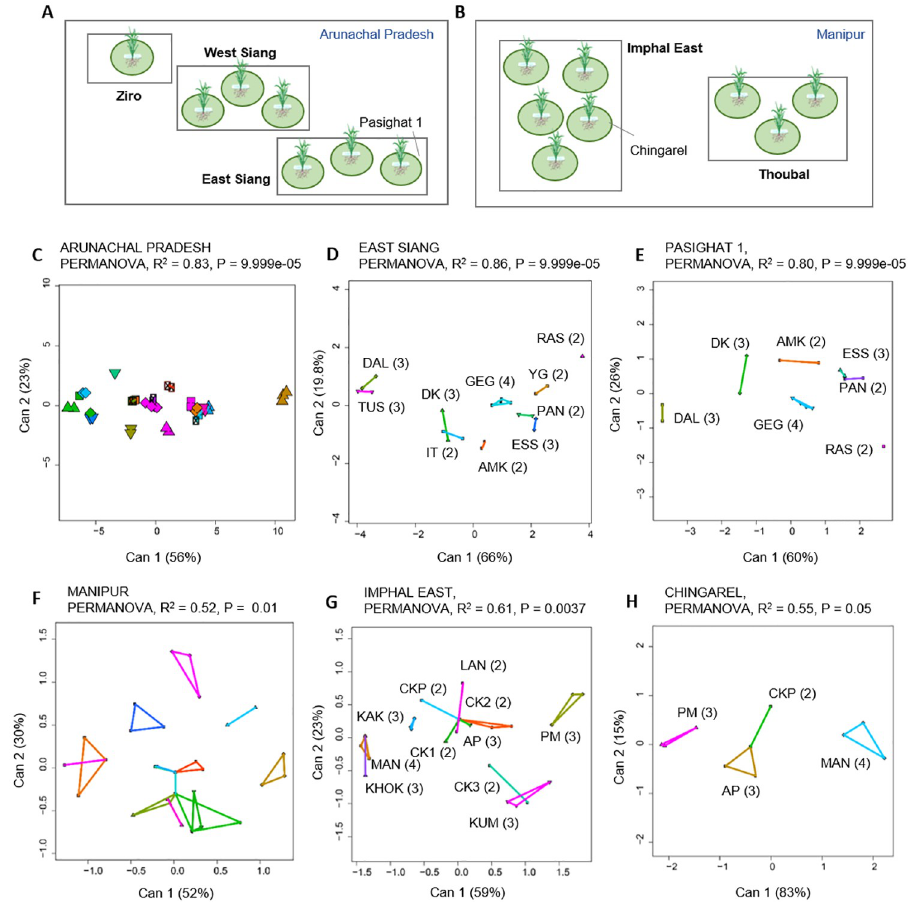
Fig 4. Phenotypic variability of Methylobacterium across spatial scales. (A–B) Schematic showing different regions (highlighted in bold) and field sites sampled in (A) Arunachal Pradesh, and (B) Manipur. Each circle represents a sampled rice field. The schematic is not to scale. (C–H) Canonical variance analysis biplots of carbon use profiles, showing the clustering of Methylobacterium isolates by landraces sampled (C) within Arunachal Pradesh, (D) within the East Siang region in Arunachal Pradesh, (E) within a single field (Pasighat 1) in Arunachal Pradesh; (F) within Manipur, (G) within the Imphal East region of Manipur, and (H) within a single field (Chingarel) in Manipur. Each point represents an isolate, and numbers in parentheses indicate the number of distinct isolates from each landrace (landrace names are abbreviated as indicated in S2 Table). In panels C and F, we omitted landrace names for clarity. In panels C–G, axis labels indicate the proportion of variation explained, and convex hulls represent 95% confidence intervals for each landrace (colors indicate different landraces).